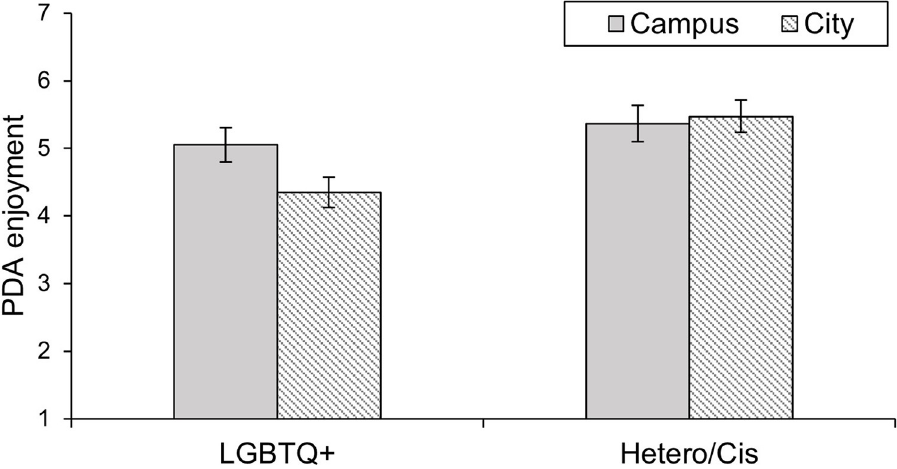
Fig 2. Reported PDA enjoyment by LGBTQ � and Hetero/Cis participants in the contexts of a campus and a city. Error bars represent +/– 1 SEM .